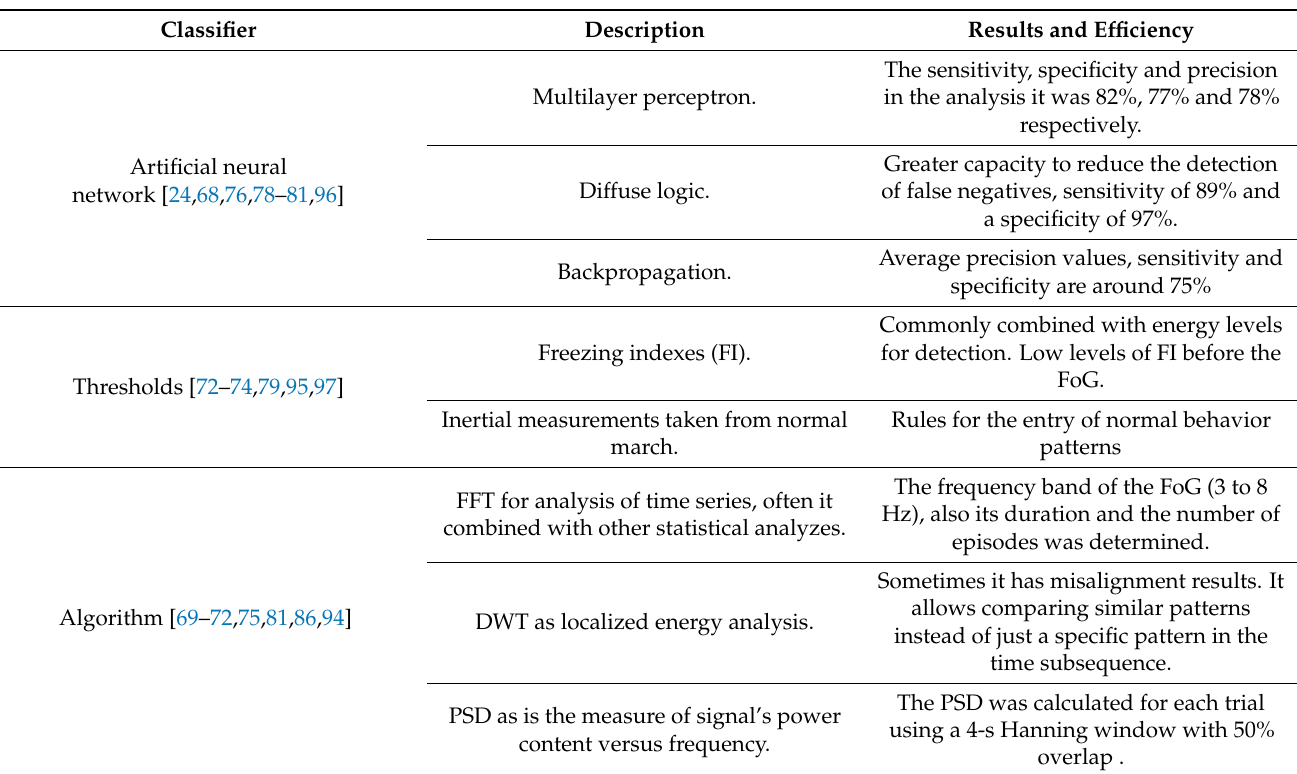
Table 2. Description of devices developed until today to help patients with episodes of FoG based in the used